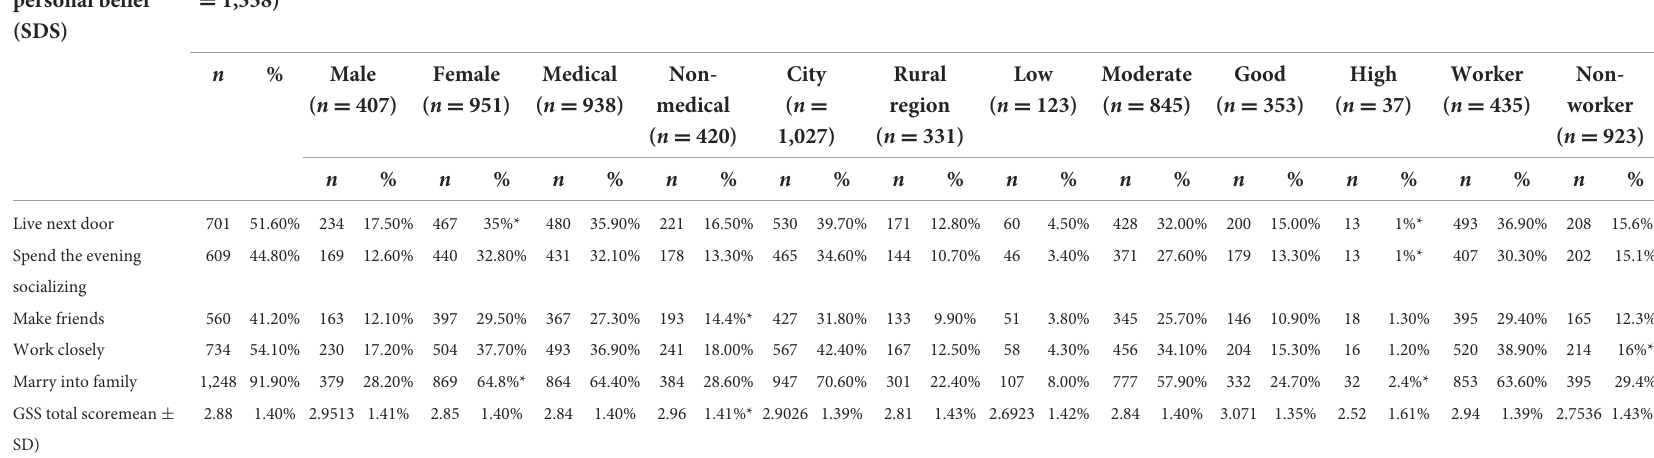
TABLE 4 Percentage of participants who are “probably unwilling” or “definitely unwilling” to have contact with GAD